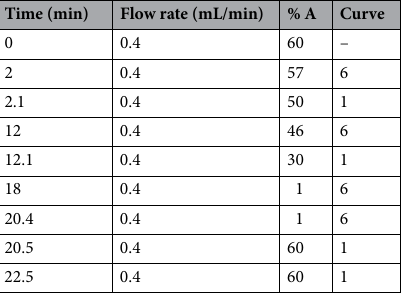
Table 1. Gradient conditions for LC–MS analysis. Online MS analysis was performed using a Xevo G2-XS Q-ToF (Waters Corporation, Manchester) in positive ion sensitivity mode over the m/z range